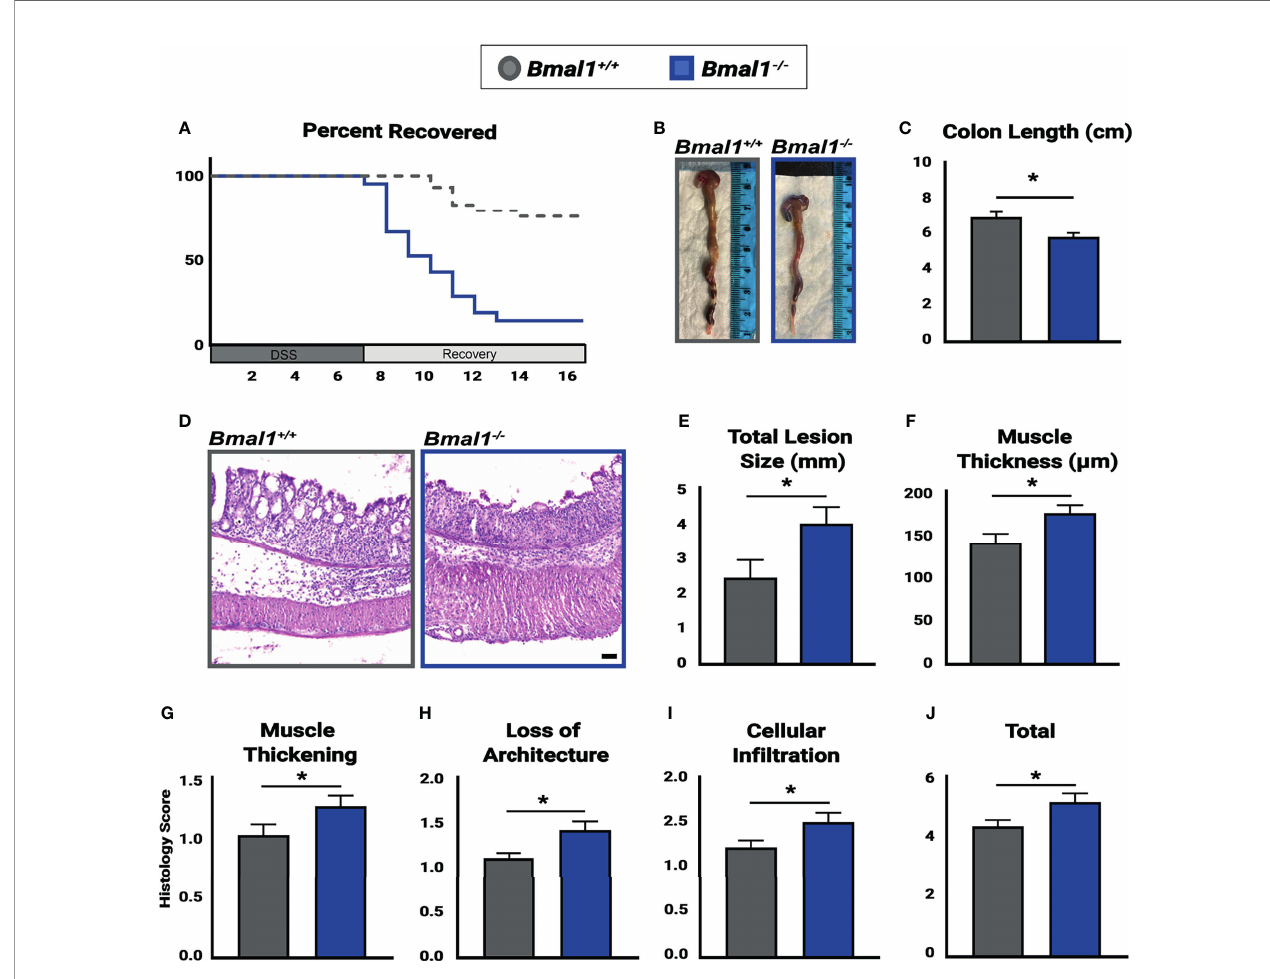
FIGURE 3 | Bmal1 -/- mutant mice have more severe colitis and increased loss of epithelial structure. Mice were treated with DSS, disease activity was monitored daily, and histopathology was determined. Colon tissues were collected at the end of DSS treatment across the full 24 hours (ZT0, ZT4, ZT8, ZT12, ZT18 & ZT20). (A) Bmal1 -/- mutant mice do not recover from colitis compared to Bmal1 +/+ controls. Kaplan-Meier curve show mutants reach study endpoint at an increased rate (Mantel-Cox test, *p<0.0001). (B) Representative images of colons. (C) Bmal1 -/- mutant mice exhibit decreased colon length. (Unpaired t -test, *p=0.0247). (D) Representative images of Hematoxylin-Eosin staining in control versus Bmal1 -/- mutants. (E) Total lesion size (area of tissue section completely lacking crypts and normal colon morphology) size throughout the colon was measured in Swiss rolls and averaged per animal. Bmal1 -/- mutant mice exhibit increased size of lesioned/ amorphous regions compared to controls. (Unpaired t -test, *p=0.0298). (F) Increased muscle thickness is also seen in Bmal1 -/- mice, indicating more severe in fl ammation (Unpaired t -test, *p=0.0201). (G – J) Histology scores were assessed based on the severity of colitis in tissue sections. Bmal1 -/- mutant tissue contains: (G) Increased muscle thickening (Unpaired t -test, *p= 0.0405); (H) Increased loss of crypt architecture (Unpaired t -test, *p=0.0072); (I) Increased cellular in fi ltration (Unpaired t -test, *p=0.0339). These factors contribute to (J) increased total histology scores in the Bmal1 -/- mutant colon with colitis (Unpaired t -test, *p=0.0234). (All error bars represent SEM. Scale bar =